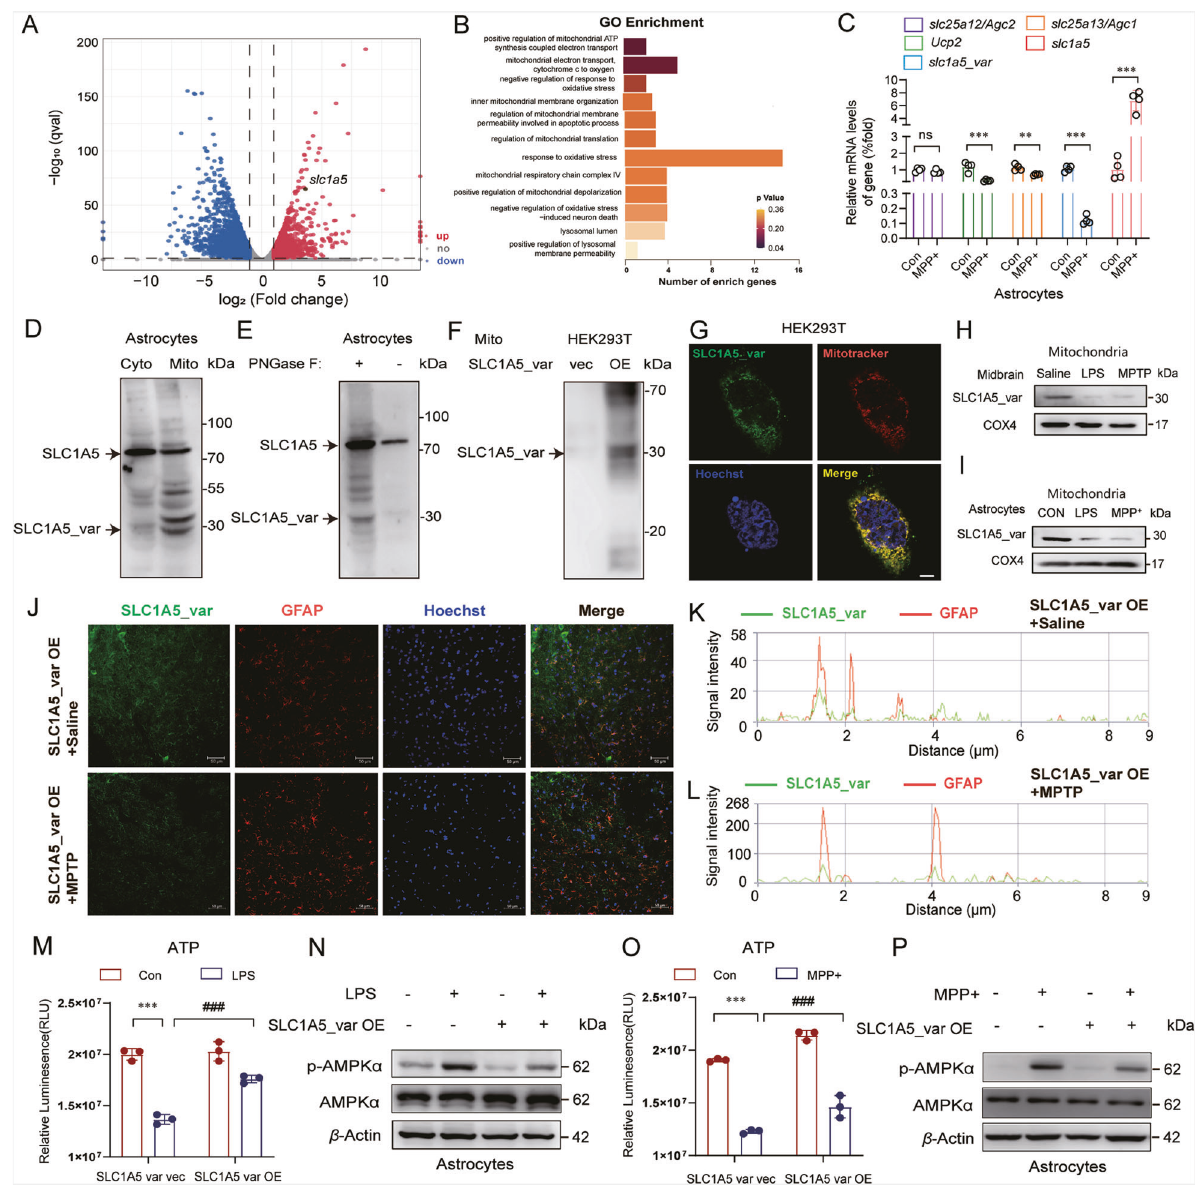
Fig. 1 Mitochondria glutamine transporter SLC1A5_var is located in astrocytes and is closely related to energy metabolism. A The volcano map of differential genes was shown while astrocytes were stimulated with MPP + ( n = 3). B Gene enrichment analysis by Gene Ontology showing the enriched pathways in astrocytes treated with MPP + . C Validation of enriched differential genes by qRT-PCR ( n = 4). D Expression of SLC1A5 and SLC1A5_var in mitochondria and cytoplasm of astrocytes was detected by immunoblotting. E Expression of SLC1A5_var was detected while treated with PNGase F in astrocytes. F Mitochondria were separated to detect the expression of SLC1A5_var in HEK-293T cells. G Immuno fl uorescence of SLC1A5_var (green) and Mitotracker (red) in HEK-293T cells. Scale bar, 50 μ m. The protein levels of SLC1A5_var in the mitochondria of the midbrain in the MPTP /LPS mice model were detected by immunoblotting ( H ). The levels of SLC1A5_var in the mitochondria of astrocytes treated with MPP + /LPS were detected by immunoblotting ( I ). J Colocalization and ( K , L ) statistics of SLC1A5_var and TH in the midbrain. Scale bar represents 50 μ m. M , O Effect of SLC1A5_var on ATP generation in the presence or absence of LPS or MPP + ( n = 3). N , P The level of p-AMPK while overexpression of SLC1A5_var in astrocytes stimulated with LPS (100 ng/ml) for 6 h or MPP + (500 μ M) for 24 h ( n = 3). Data are shown as the mean ± S.E.M. ns, P > 0.05, ** P < 0.01 and *** P < 0.001 using the Student ’ s t test ( C , J – M ). ** P < 0.01 and *** P < 0.001 vs control, # P < 0.05, ### P < 0.001 vs LPS group, two-way ANOVA followed by Tukey ’ s post hoc test ( N , P , Q ).